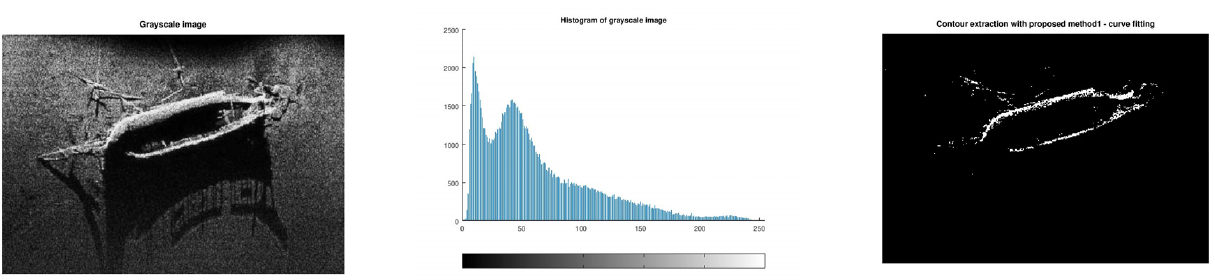
Figure 22. Results for test image shipwreck world.